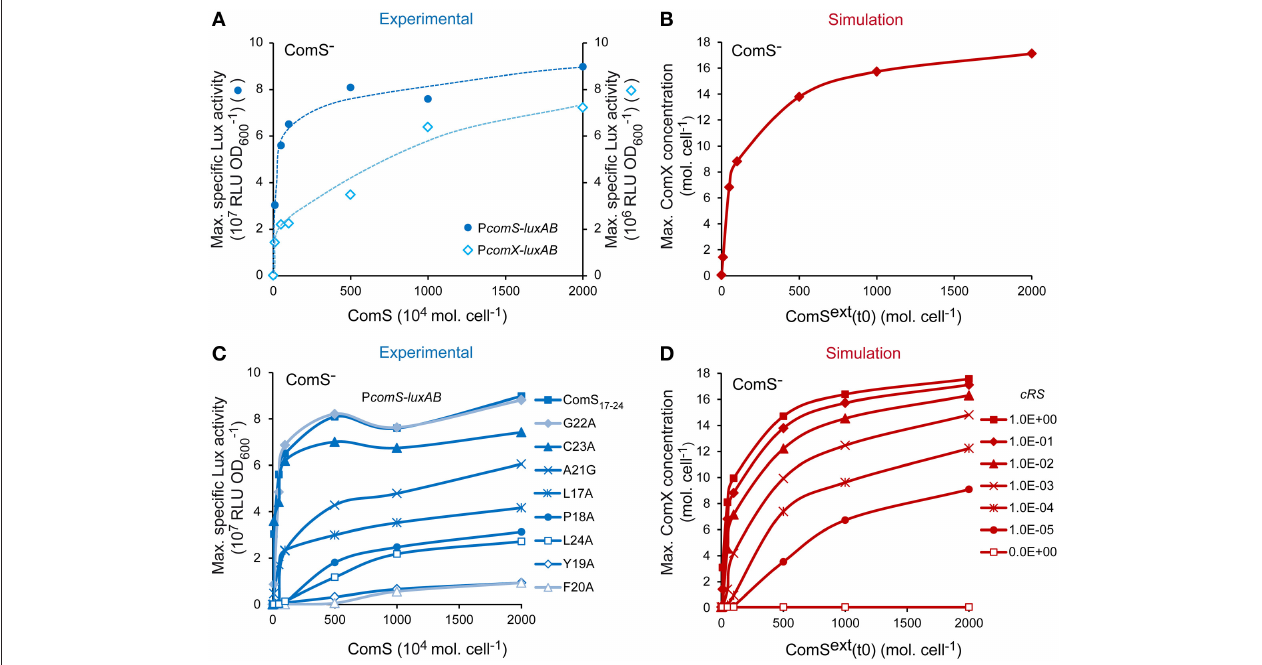
FIGURE 3 | Validation of the reactivity of the ComRS model. (A) Maximum specific luciferase activity (RLU OD − 1 600 ) driven by P comX and P comS in the ComS − strains LF118 and LF134, respectively, in response to increasing ComS 17 - 24 concentrations. (B) In silico computation of the maximum ComX concentrations (molecules (mol.) cell − 1 ) reached in response to increasing initial ComS ext concentrations (mol. cell − 1 ) in a simulated ComS − background. (C) Impact of the systematic replacement of each amino acid residue of ComS 17 - 24 with Alanine on the reactivity of the P comS - luxAB fusion in ComS − strain (LF134). Graph shows the maximum RLU OD − 1 600 measured after addition of increasing peptides concentrations (D) In silico impact of decreasing the affinity between ComR and ComS on the maximum ComX concentrations (mol. cell − 1 ) reached. This was done by decreasing the value of the ComRS complex formation rate constant c RS by 10-fold steps. Concentrations of ComS ext (mol. cell − 1 ) and ComS 17 - 24 (nM) used are 0, 10, 50, 100, 500, 1000, and 2000. To enable comparison between in silico and in vitro experiments, experimental nanomolar units of ComS (17 - 24) were converted in 10 4 mol. cell − 1 by assuming a density of 5 10 7 cells ml − 1 at the moment of peptide × addition (i.e., after 1h of incubation in CDML). (A,C) The results of one representative experiment are